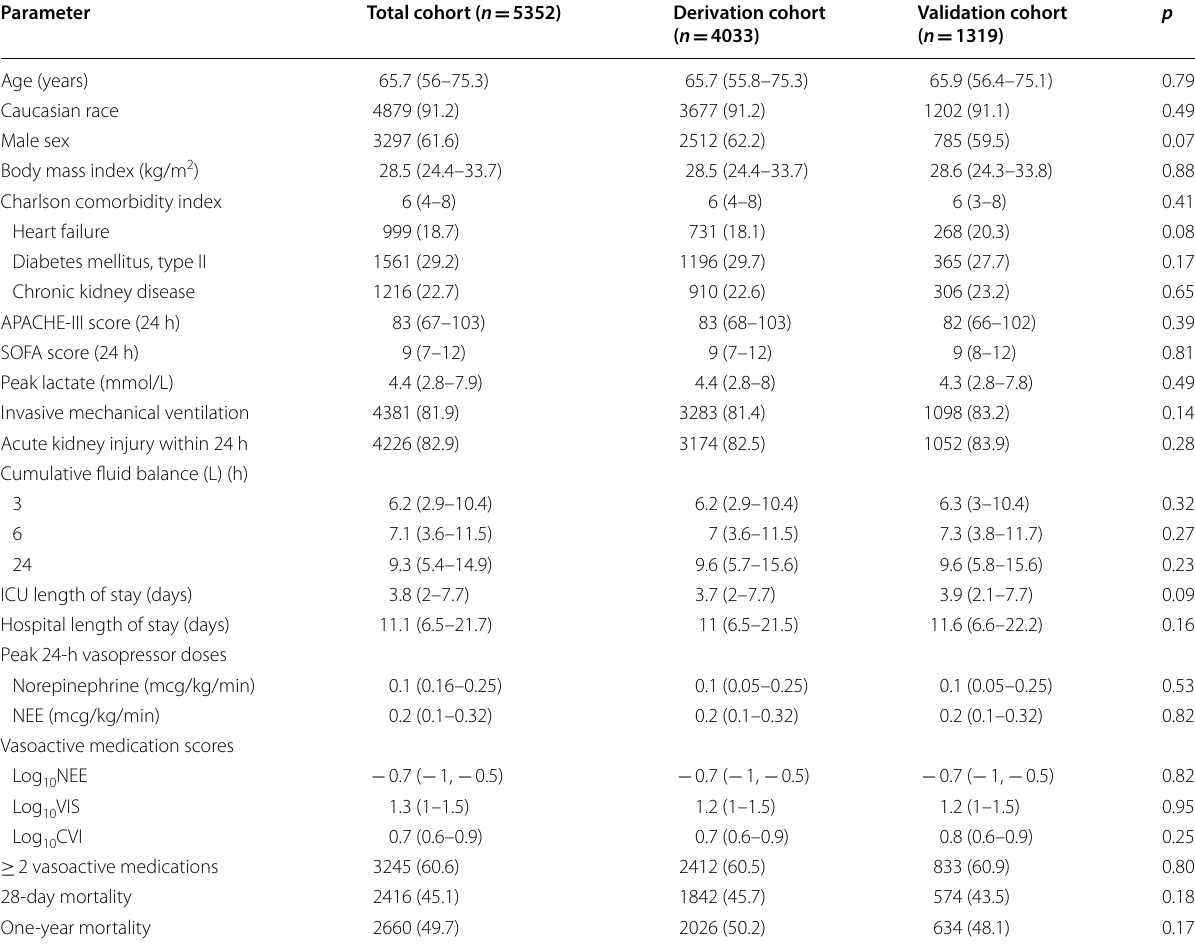
Count (percentage) or median (interquartile